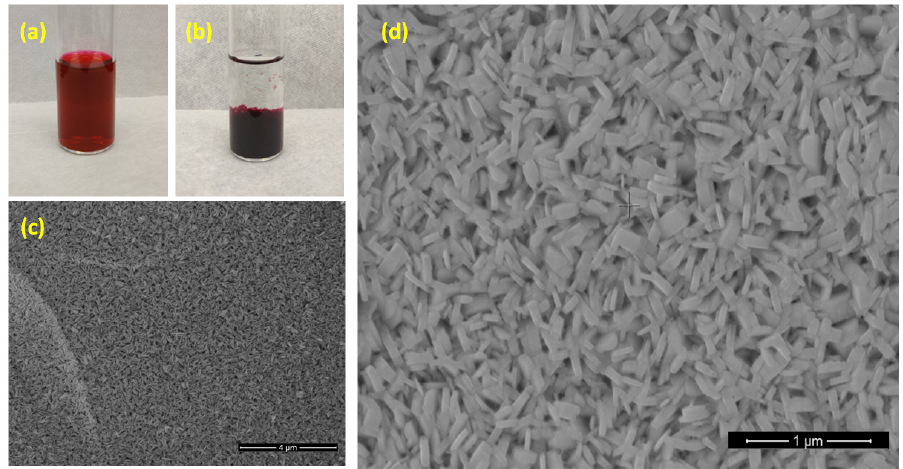
Figure 2. ( a ) The digital image of the 1 mM APBI-K aqueous solution. ( b ) The digital image of the